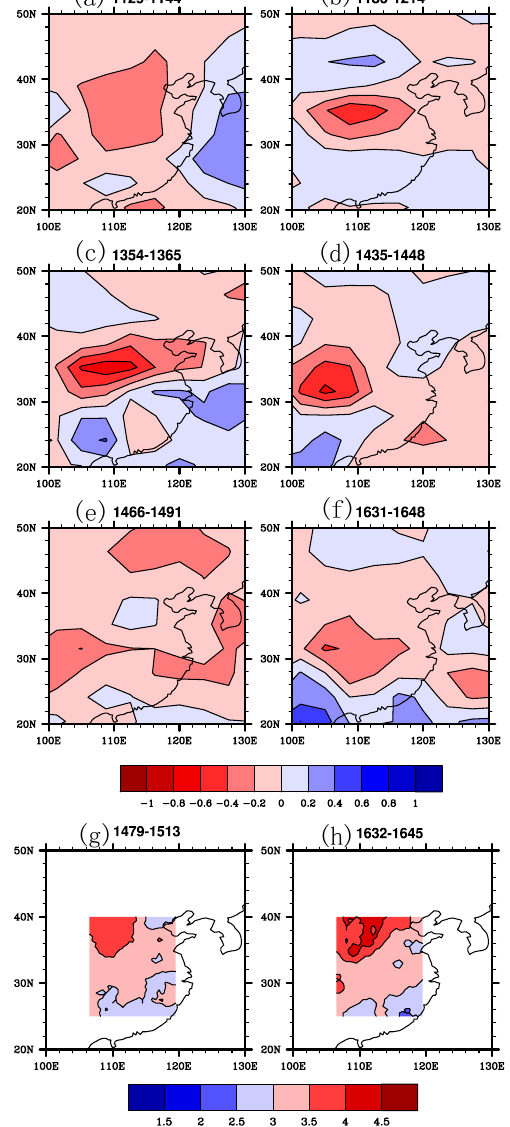
Figure 2. Modeled precipitation anomalies (mmday − 1 ) of the six well-captured droughts (a–f) and the last two regional droughts identified from the historical records from the periods 1479– 1513 (g) and 1632–1645 (h)